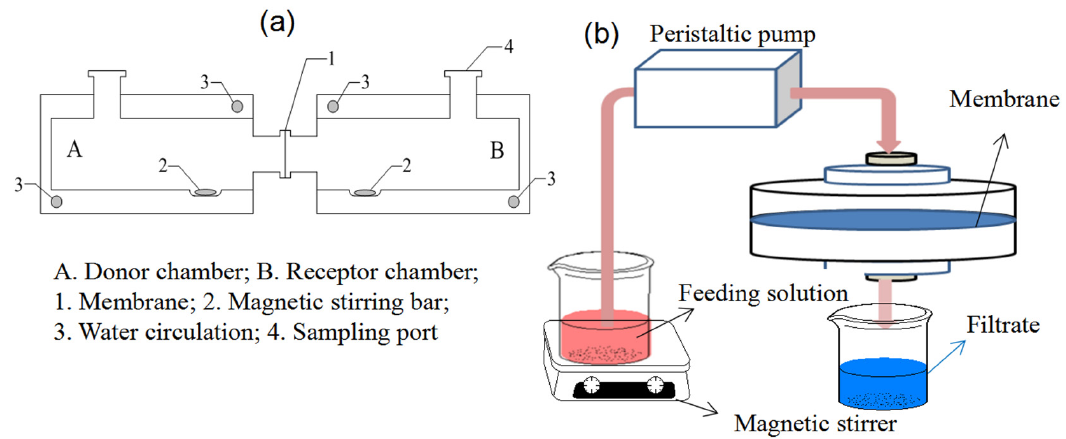
Figure 12. The membrane permeation ( a ) and dead-end filtration experimental ( b ) setups. In Figure 12b, the dynamic adsorptions were performed on the dead-end filtration apparatus. The BSA/BHb mixed solution (0.2 mg mL − 1 for each protein) at 25 ◦ C was filtrated through the membrane at 1.25 mL min − 1 of the flow rate by a peristaltic pump, and protein concentration in the filtrates was measured at a predetermined time